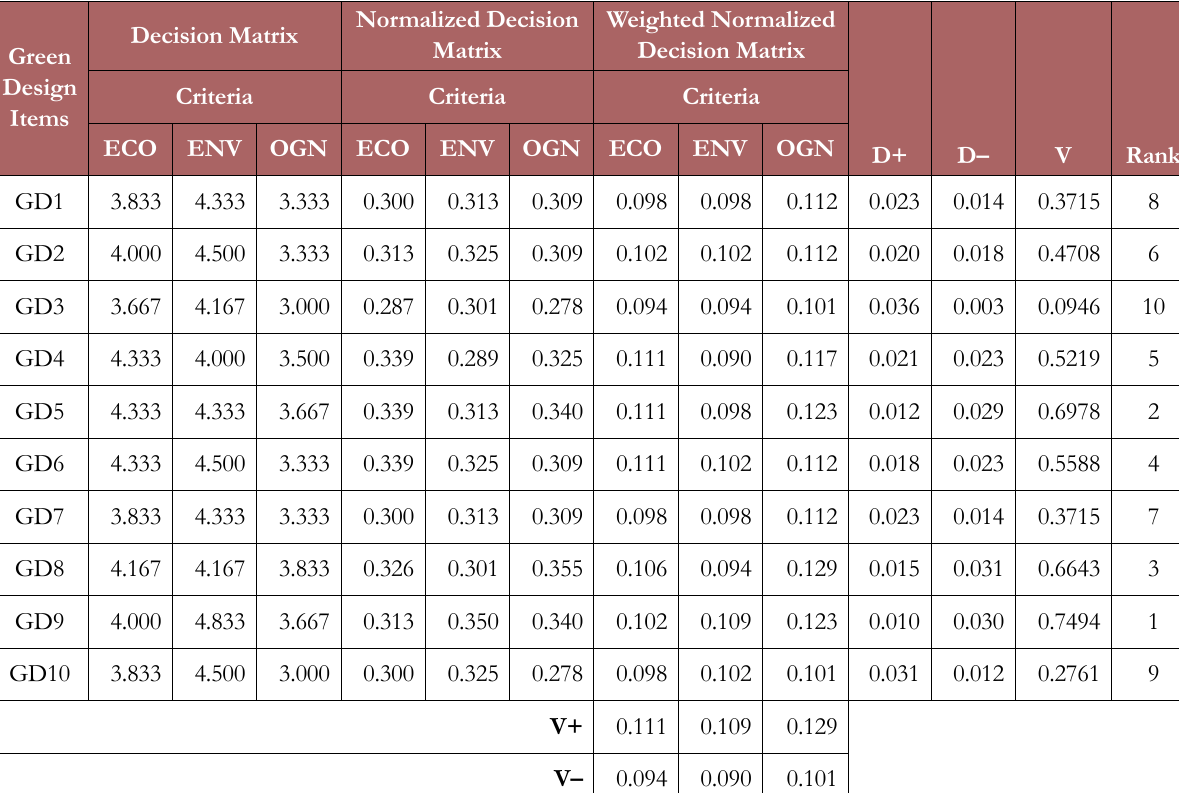
Table 7. TOPSIS Analysis for Green Design Practices